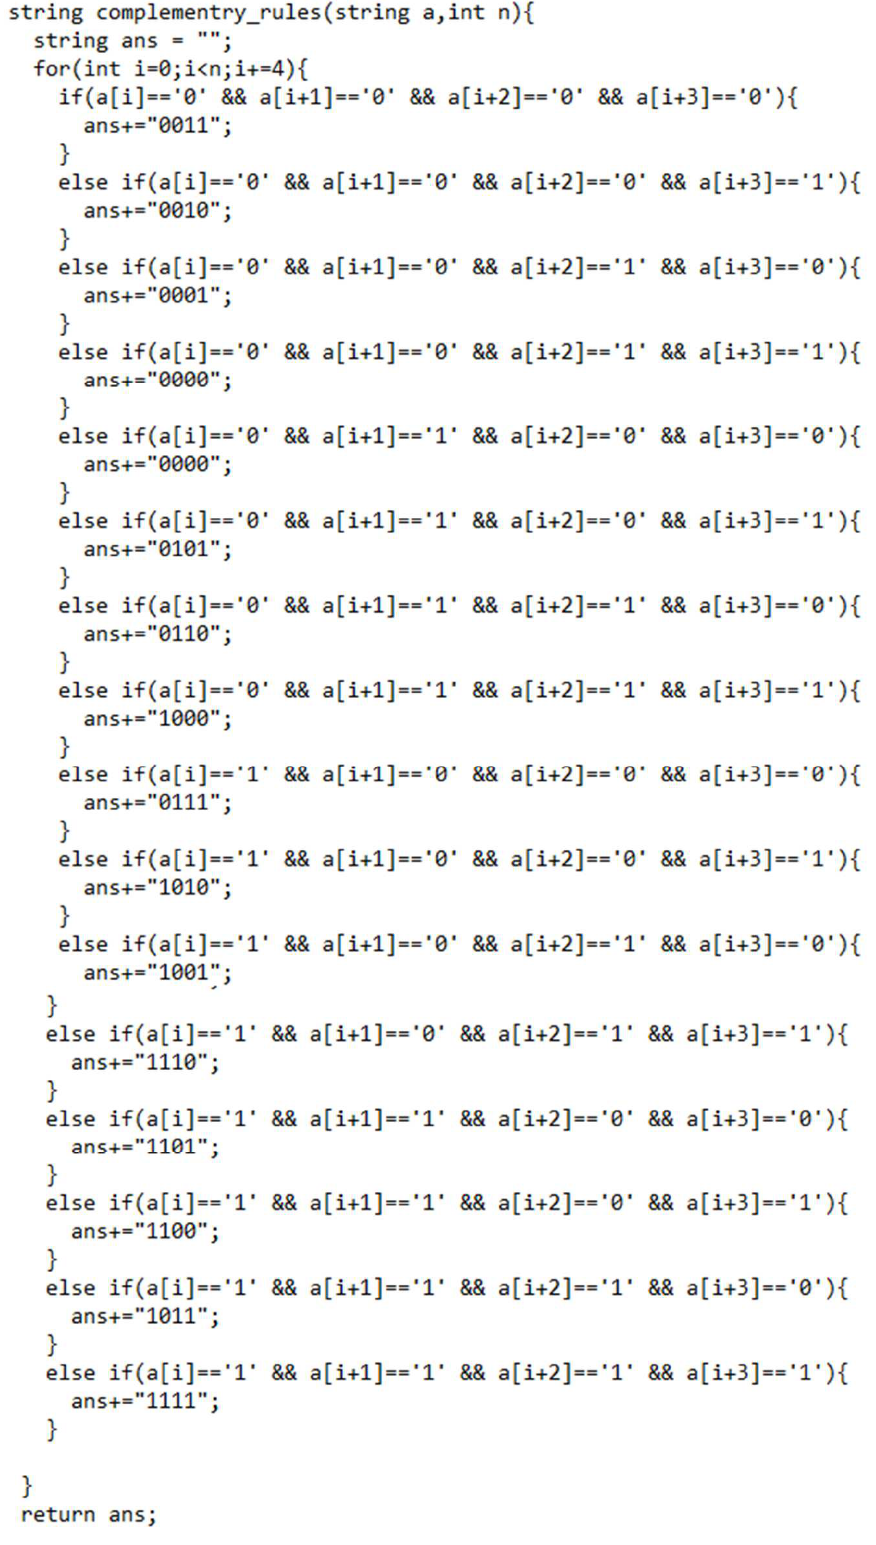
Figure A3. Complementry mapping rules .